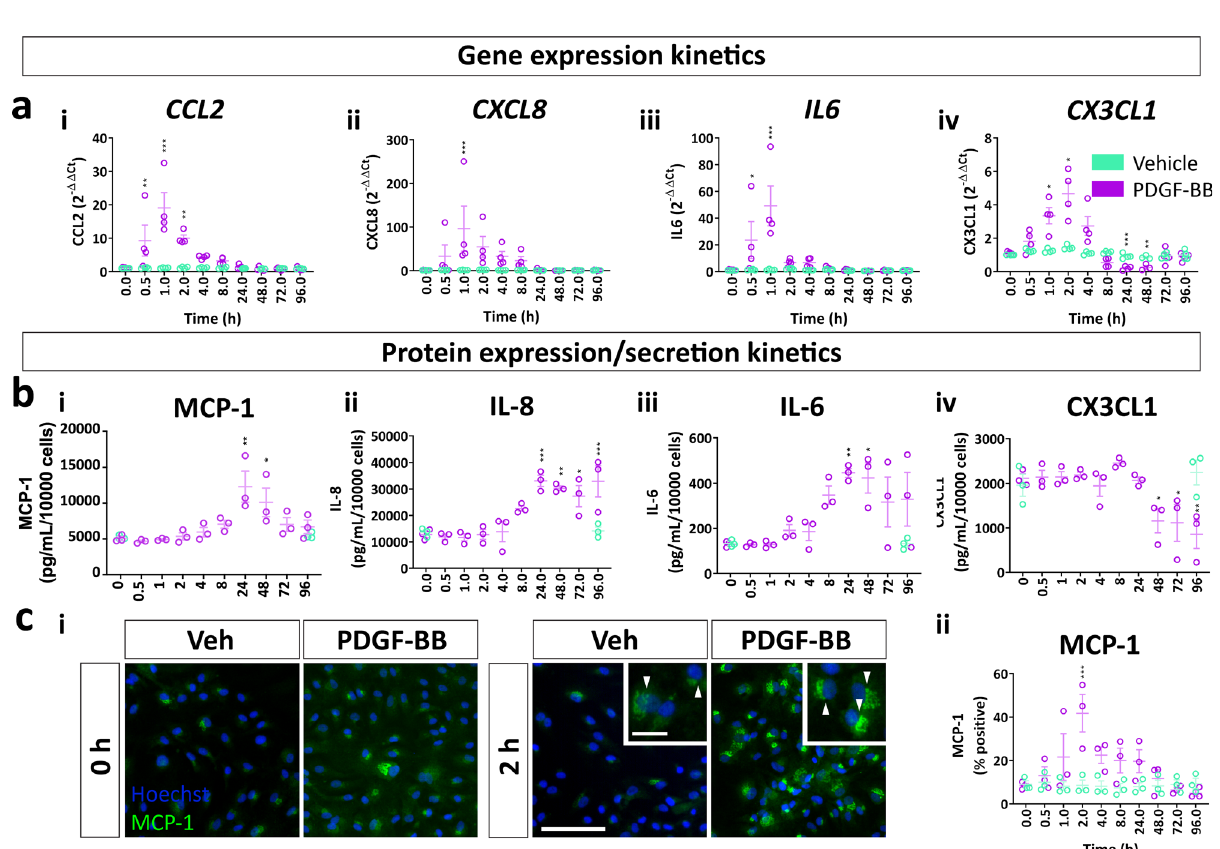
Fig. 8 PDGF-BB alters pericyte in fl ammatory secretions. Pericytes were treated with PDGF-BB (10ng/mL) or vehicle for up to 96h, RNA extracted at endpoint and qPCR performed. a Kinetics of CCL2, CXCL8, IL6 and CX3CL1 induced by PDGF-BB expression. n = 4, two-way ANOVA. Pericytes were treated with PDGF-BB (10ng/mL) or vehicle for up to 96h, then fi xed at endpoint and conditioned media collected. Samples were then immunostained and secretions